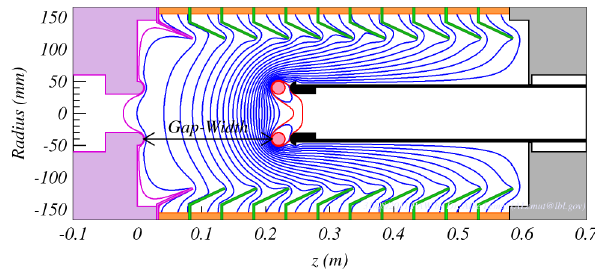
FIG. 7. Schematic of the accelerator column and movable screening electrode. The high-voltage electrode (magenta, on the left), the negative screening ring (red, electrically insulated), the movable ground tube ground (black), the ceramic insulators (orange), and the uniformly voltage graded accelerator rings are also shown (green). The first ring (magenta) is at platform potential. The equipotential lines for a 150 kV postacceleration voltage (200 mm gap width) are shown in blue. The (cid:1) 200 V (red) and 149.8 kV (magenta) equipotential lines indicate the area where the beam is transported with full space charge applied. In order to accommodate large beam radii, the accel- eration electrode assembly has an inner radius of 30